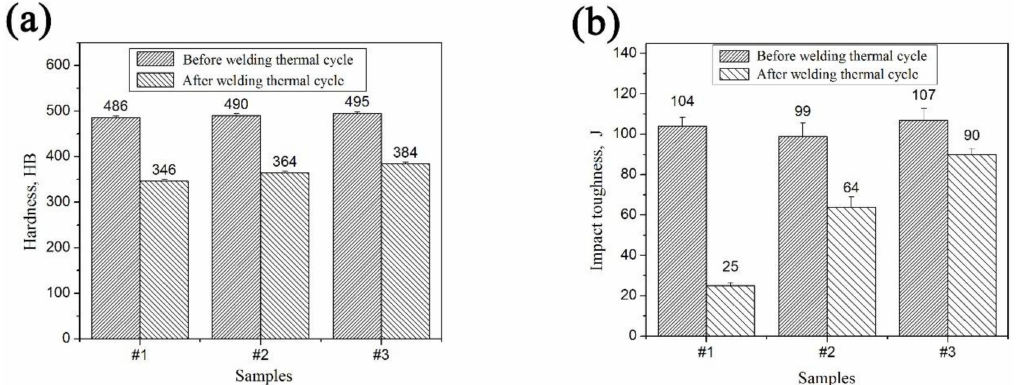
Figure 12. Compared hardness ( a ) and impact toughness ( b ) before and after welding thermal